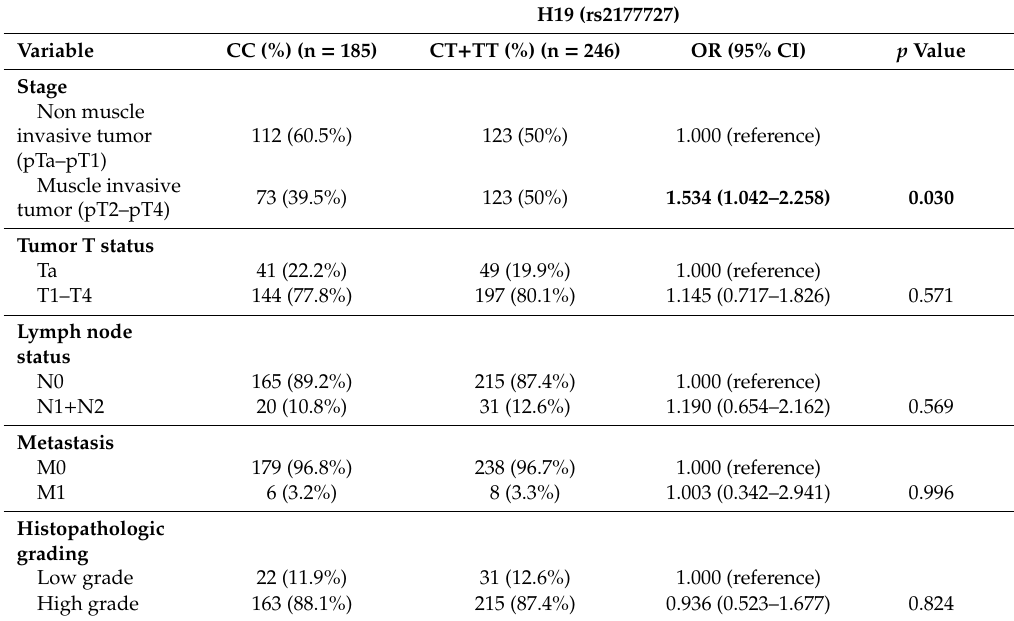
Table 3. Distribution frequency of the clinical status and H19 rs2177727 genotype frequencies in 431 UCC patients.